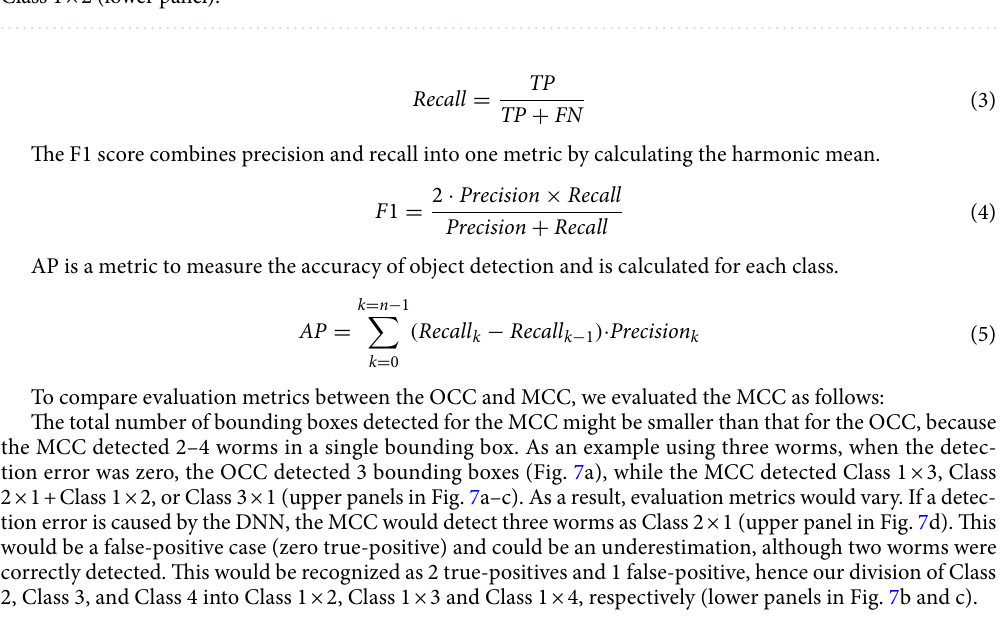
Figure 7. Examples of predicted classes for three worms with the multi-class classification (MCC). When the detection error is zero, (a) three worms are detected as ( a ) Class 1 × 1 (upper panel), and it is divided into Class1 × 1 (lower panel), this is same with the one-class classification (OCC), ( b ) Class 2 × 1 and Class 1 × 1 (upper panel), and it is divided into Class 1 × 3 (lower panel), ( c ) Class 3 × 1 (upper panel), and it is divided into Class1 × 3 (lower panel). ( d ) While the detection error is caused, Class 2 × 1 (upper panel), and it is divided into Class 1 × 2 (lower